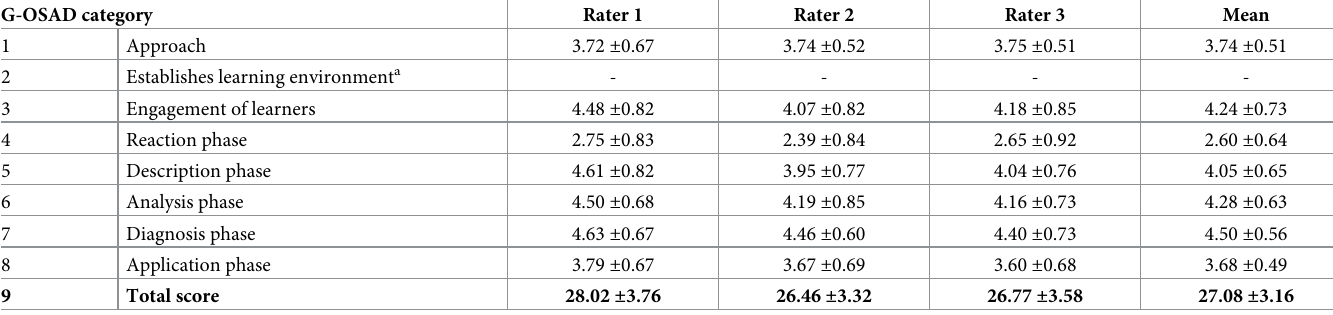
Table 1. Descriptive statistics of the G-OSAD ratings of the three trained raters across all of the debriefings (N = 57). G-OSAD